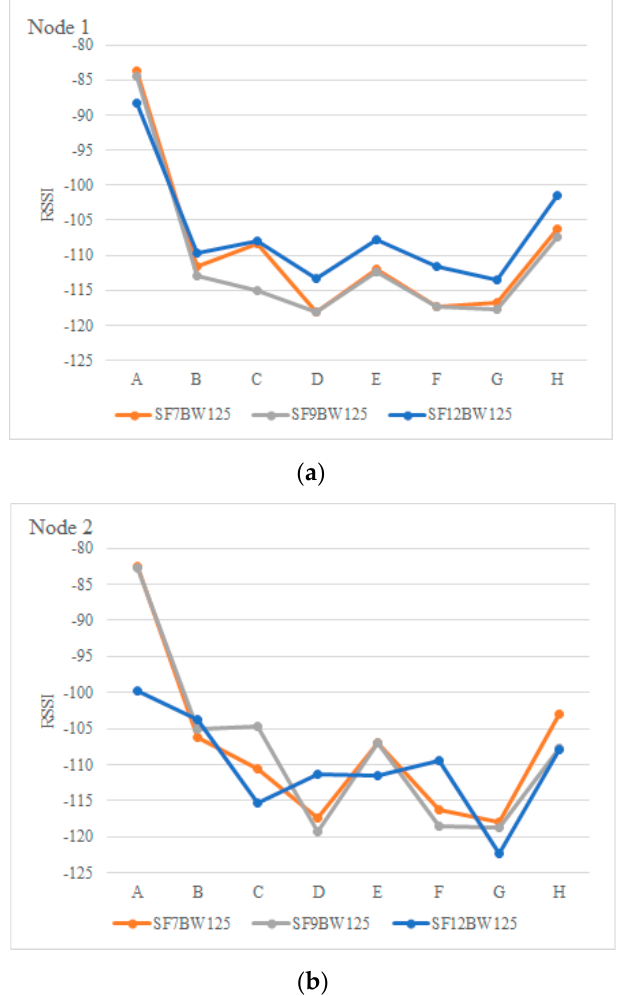
Figure 13. RSSI of the radio (dBm): ( a ) Node 1, ( b ) Node 2.